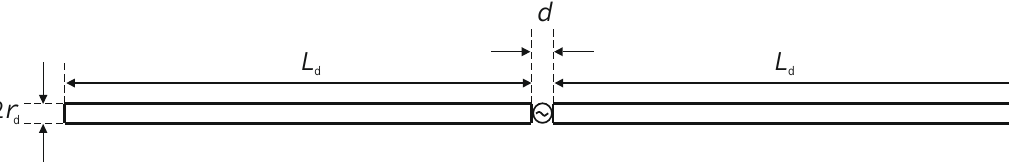
Figure 12. View of the dipole antenna including dimensions ( d = 1 mm, L d = 50 mm, r d = 1 mm) and the sinusoidal voltage dipole source.